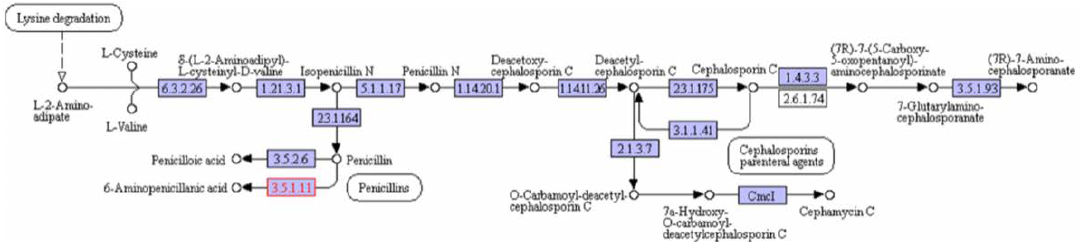
Figure 6. Representation of metabolic pathway performed on KEGG website. The map shows the pathway of secondary metabolite biosynthesis. In red color are represented the enzymes found in transcriptome and proteome of W. magna.